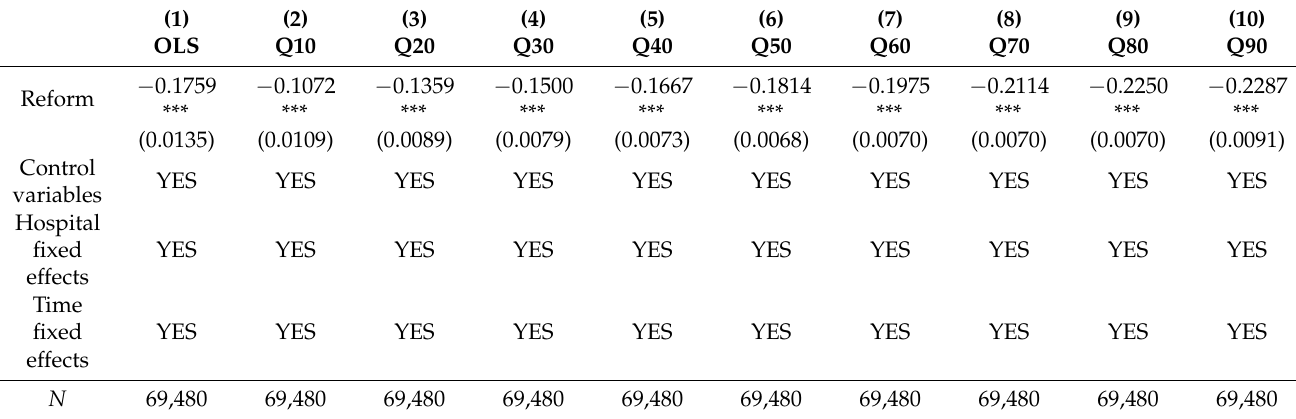
Table 3. Quantile difference-in-differences estimates of medical costs.